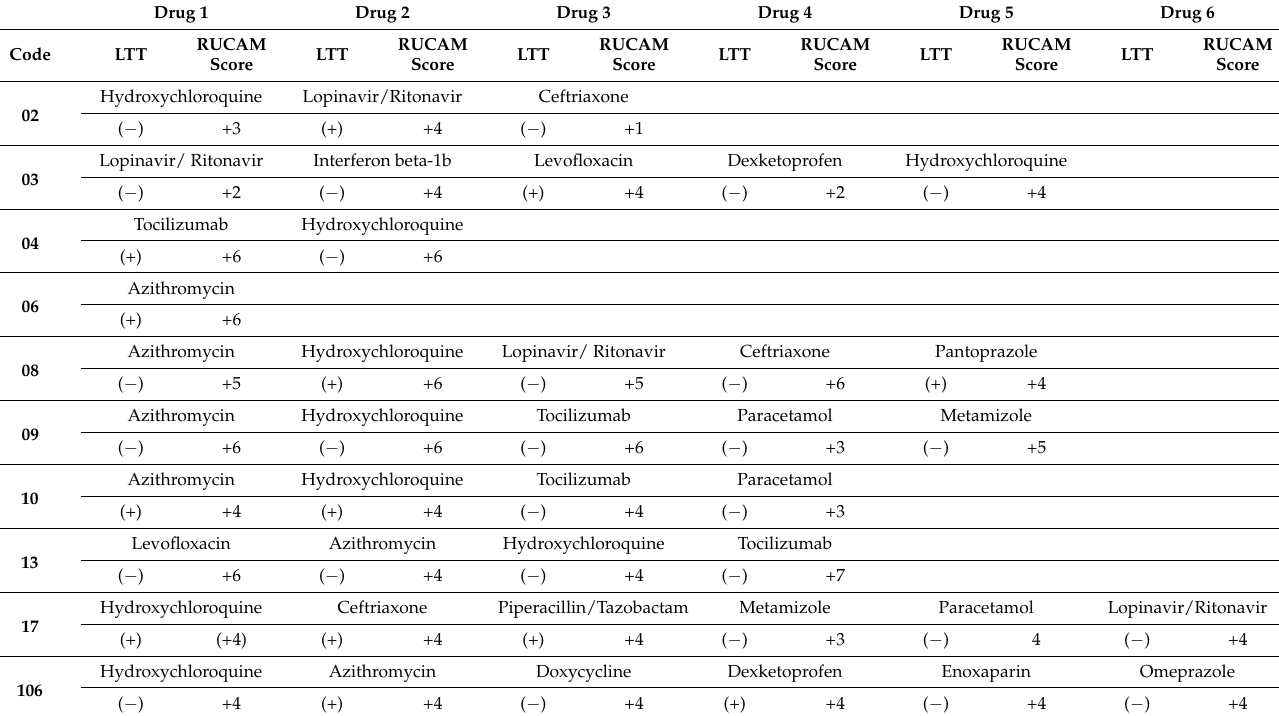
Table 6. RUCAM concordance with